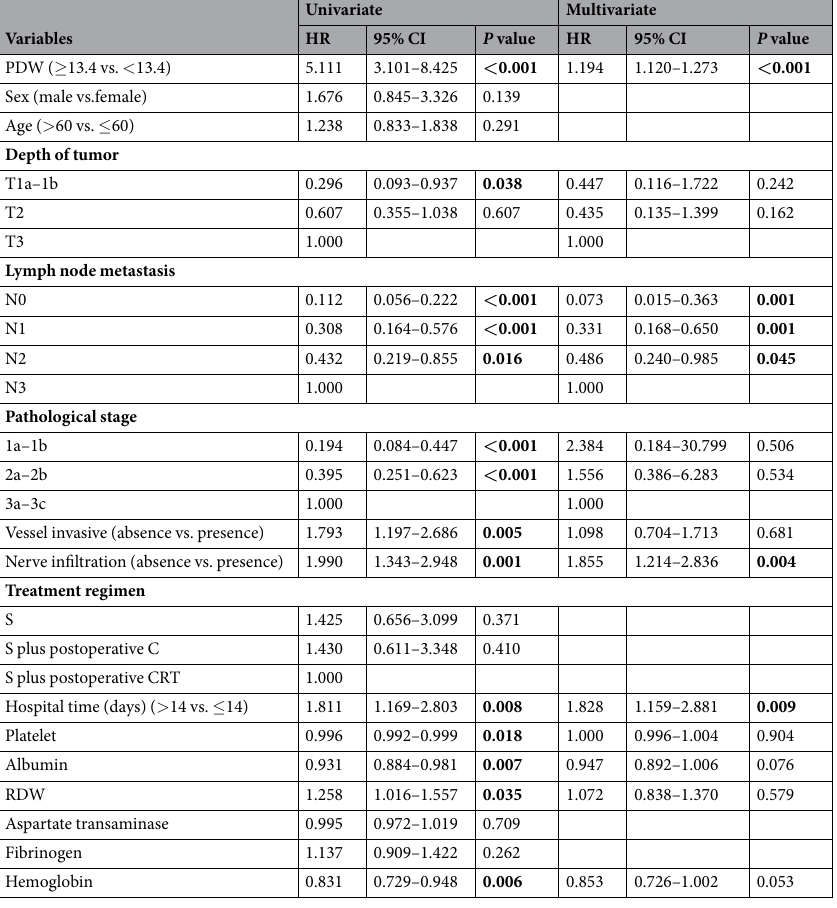
Table 4. Overall survival analyses according to preoperative PDW in 495 patients with ESCC. Abbreviations: S, surgery; C, chemotherapy; CRT, chemoradiotherapy; PDW, platelet distribution width; RDW, red cell distribution